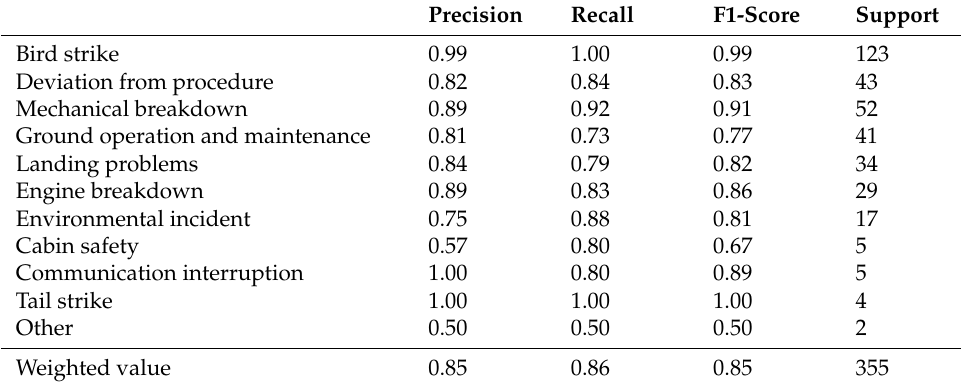
Table 5. Final classification results.